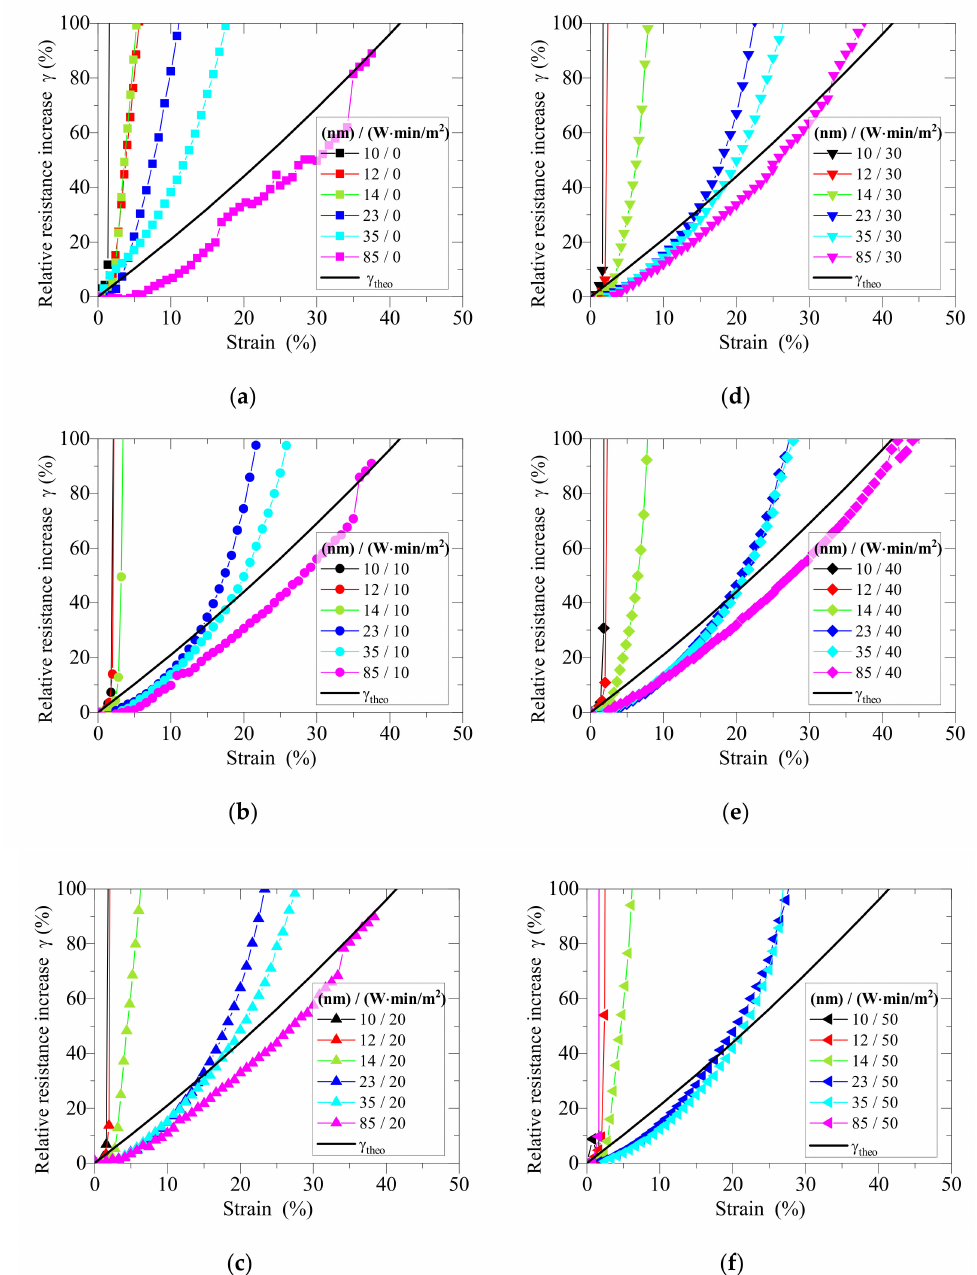
Figure 10. Increase in resistance under strain for PP films pretreated with di ff erent corona dosages: ( a ) 0; ( b ) 10; ( c ) 20; ( d ) 30; ( e ) 40 and ( f ) 50 W · min / m 2 . Colored lines in each graph represent di ff erent aluminum thicknesses ranging from 10 to 85 nm. Each value is a mean of n = 5 measurements. As was the case for the PET films, thick coatings (85 nm, pink lines) showed a behavior close to the theoretical increase in resistance ( γ theo ) represented by the black lines, whereas thinner coatings were much more sensitive to strain. This e ff ect appeared to be independent of the corona treatment, given the similar appearance of all the graphs in Figure